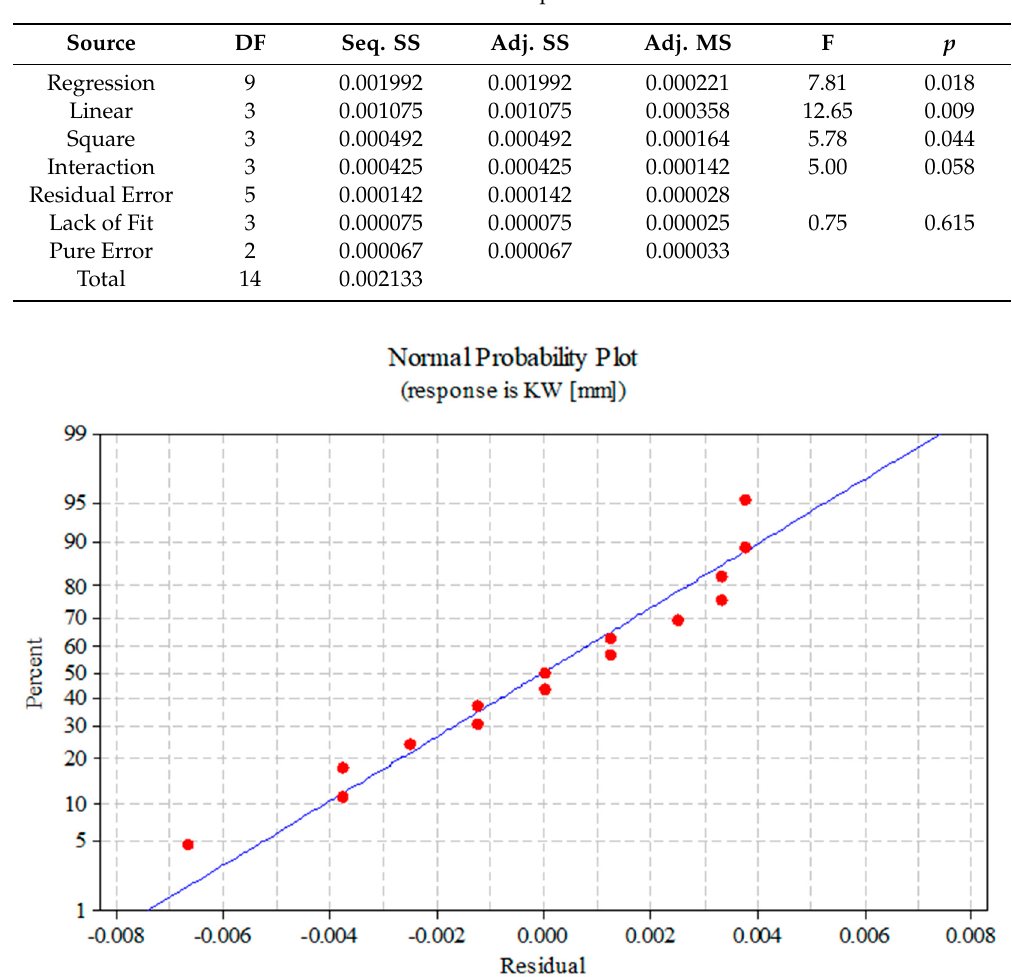
Figure 5. Normal probability plot of the residuals for KW.